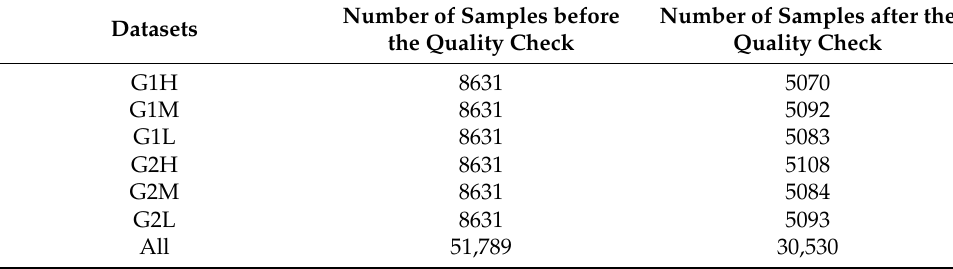
Table 3. Data pool after data quality